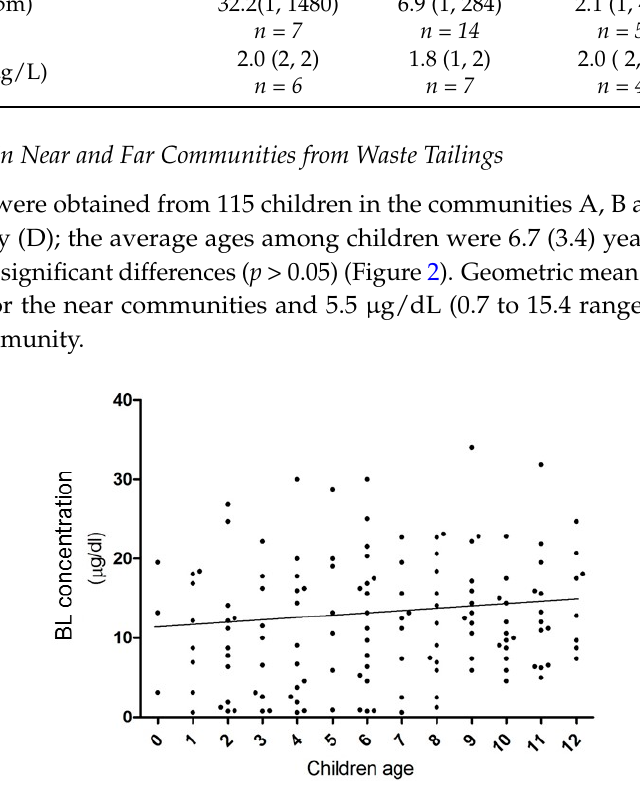
Table 1. Lead concentration in environmental samples of populations near mining waste sites.